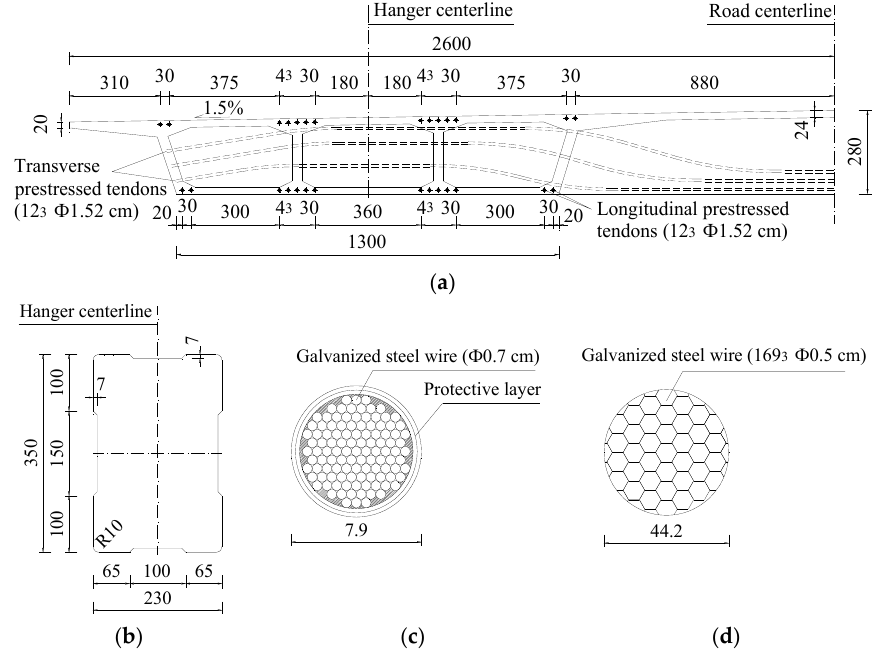
Figure 3. Cross section of key component: ( a ) half part of girder, ( b ) tower, ( c ) hanger, and ( d ) cable (Unit: cm).